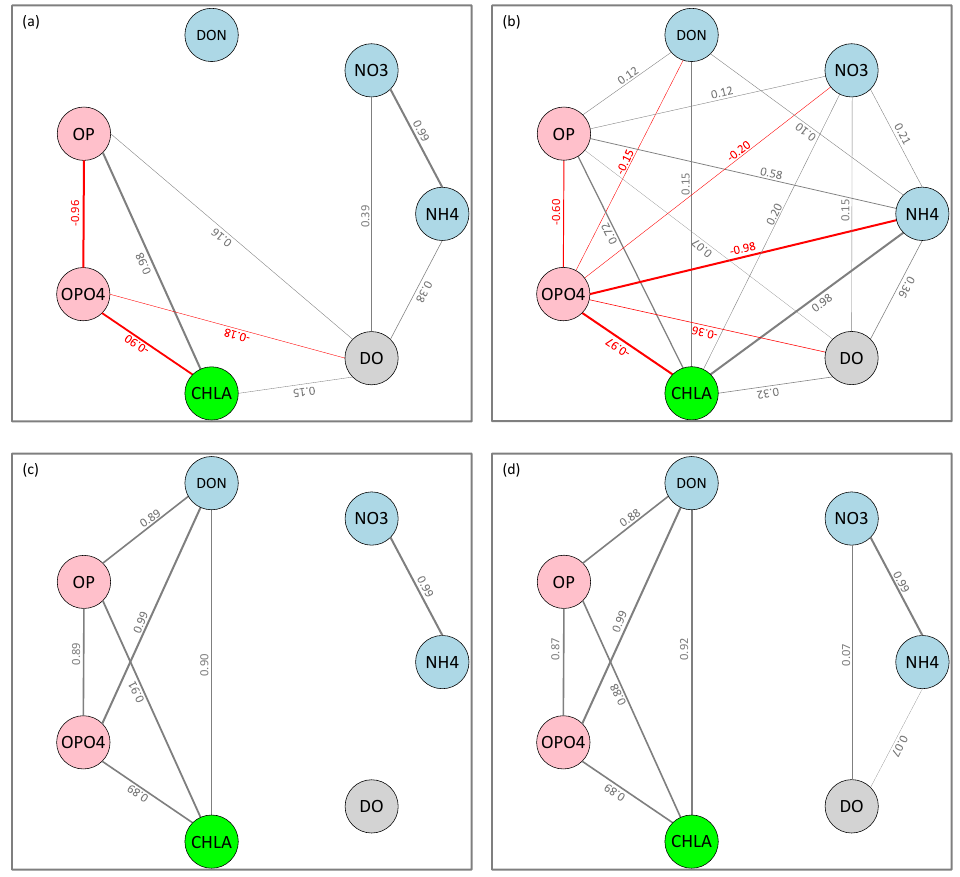
Figure 7. Correlation between variables. ( a ) uSSR at Medicine Hat; ( b ) uSSR at Leader; ( c ) lSSR at Outlook, and ( d ) lSSR at Clarkboro Ferry.